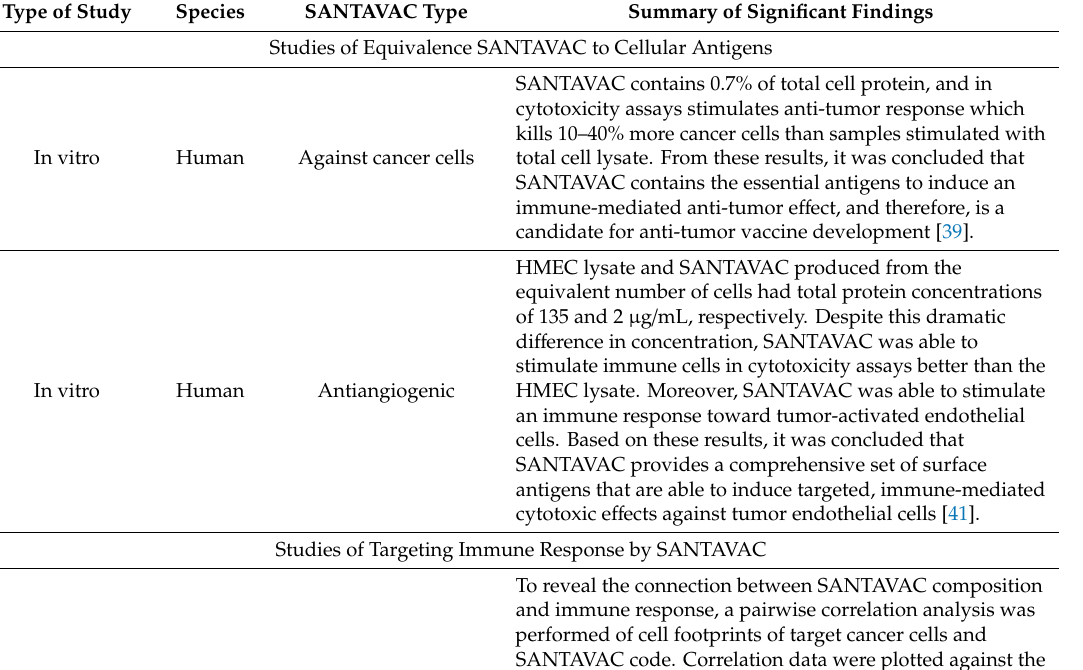
Table A1. Summary of nonclinical studies related to